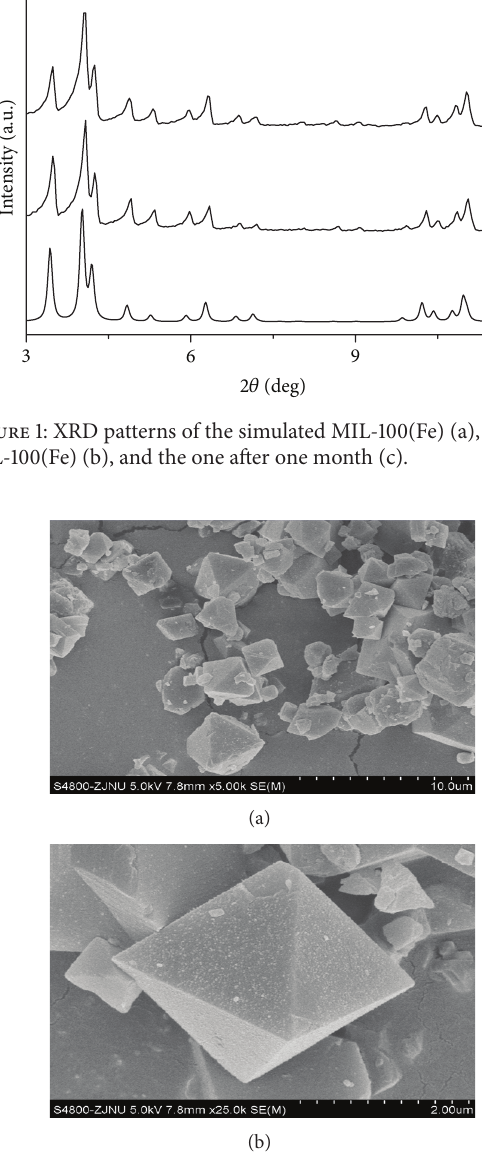
Figure 2: SEM images with different scale